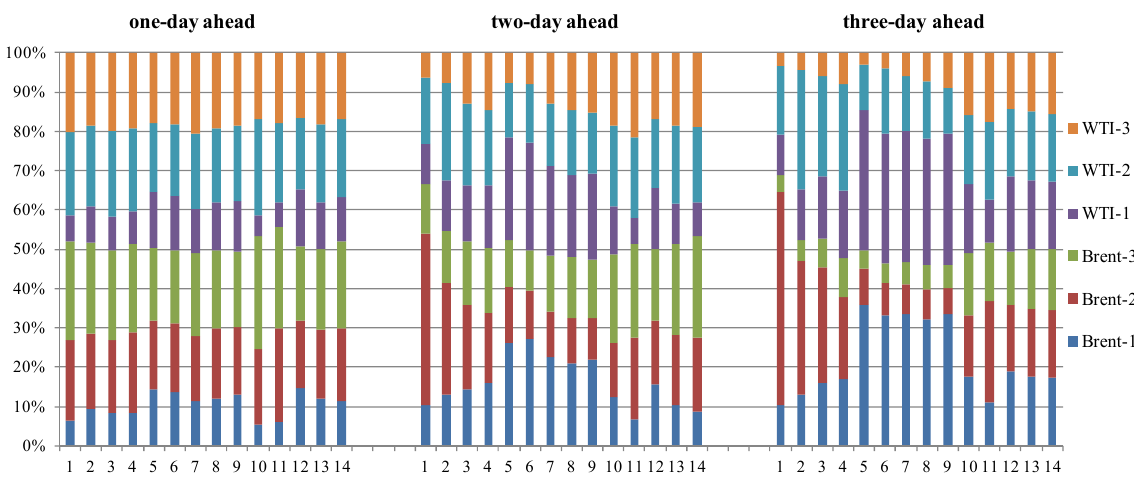
Figure 4. Coefficients of MKR of one-day, two-day, and three-day ahead predictions for Brent Crude oil price (14 experiments for each time